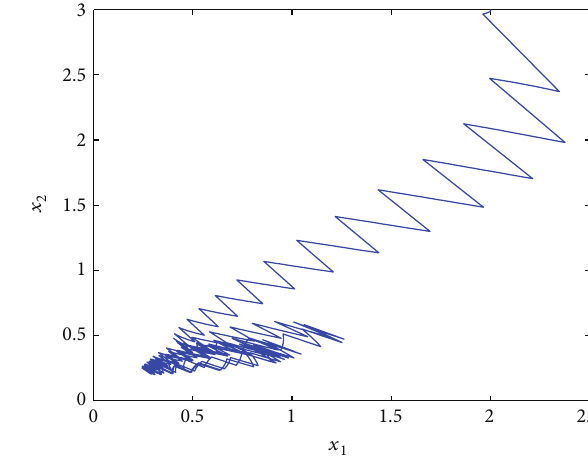
Figure 3: The time series and phase of the extinction of species 𝑥 .